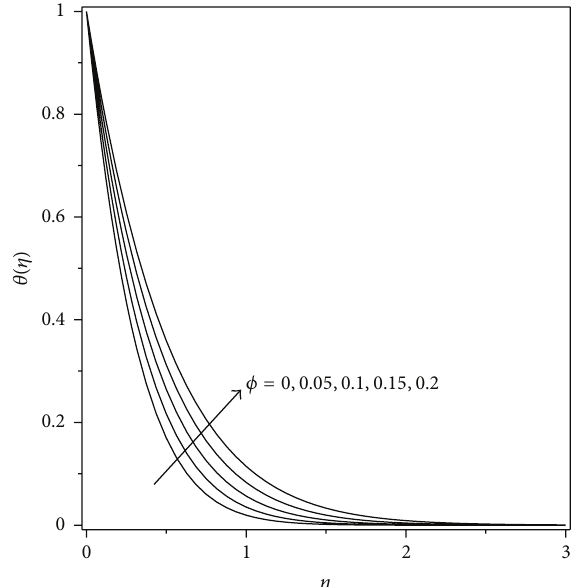
Figure 9: Dimensionless temperature profiles 𝜃(𝜂) for Al 2 O 3 nanoparticles with 𝑚 = 0 and various values of 𝜙 .